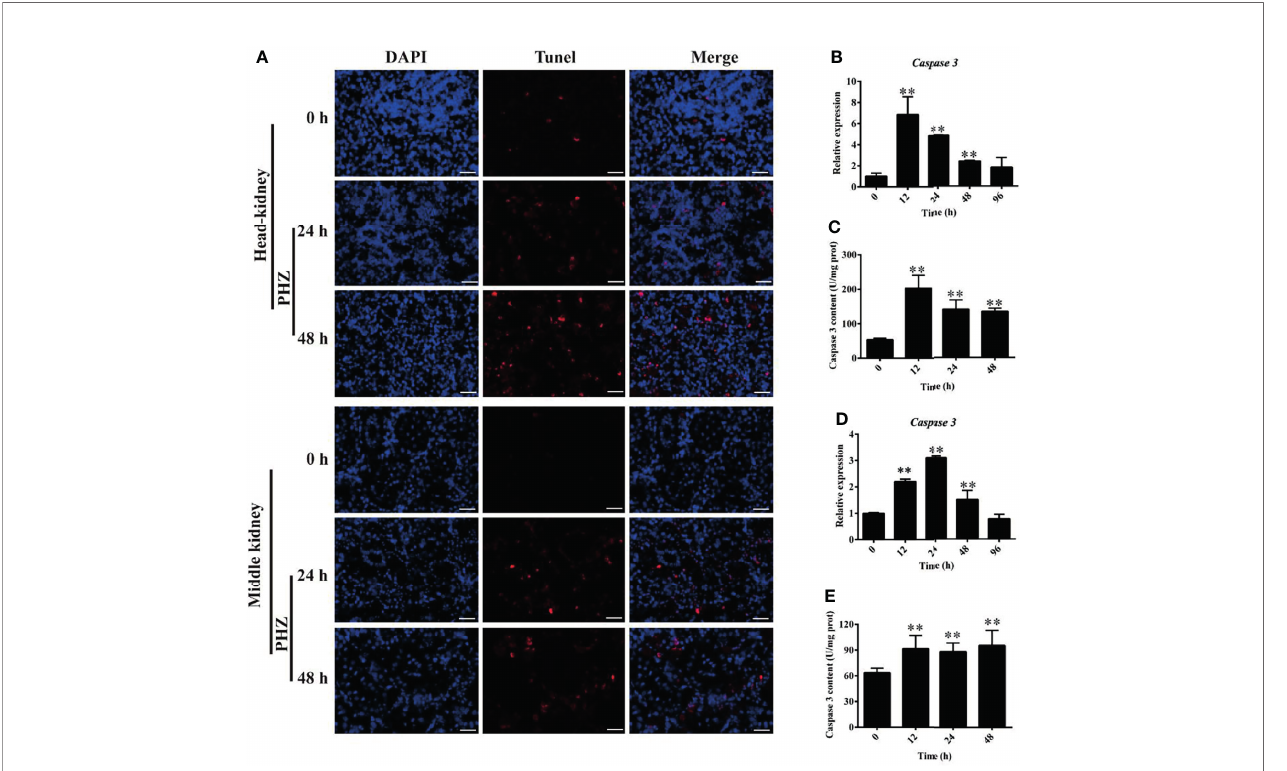
FIGURE 6 | Hemolysis induced apoptosis in the head and middle kidney. (A) TUNEL staining showing apoptosis in red after phenylhydrazine (PHZ)-induced hemolysis at 24 and 48 h in the head and middle kidney. Scale bar , 40 m m. (B, D) Expression of caspase 3 in the head (B) and middle (D) kidney after PHZ-induced hemolysis at 24 and 48 h (C, E) Content of caspase 3 in the head (C) and middle (E) kidney after PHZ-induced hemolysis at 24 and 48 h ** p < 0.01 (Student ’ s t -test). Data represent the mean ± SD of three independent